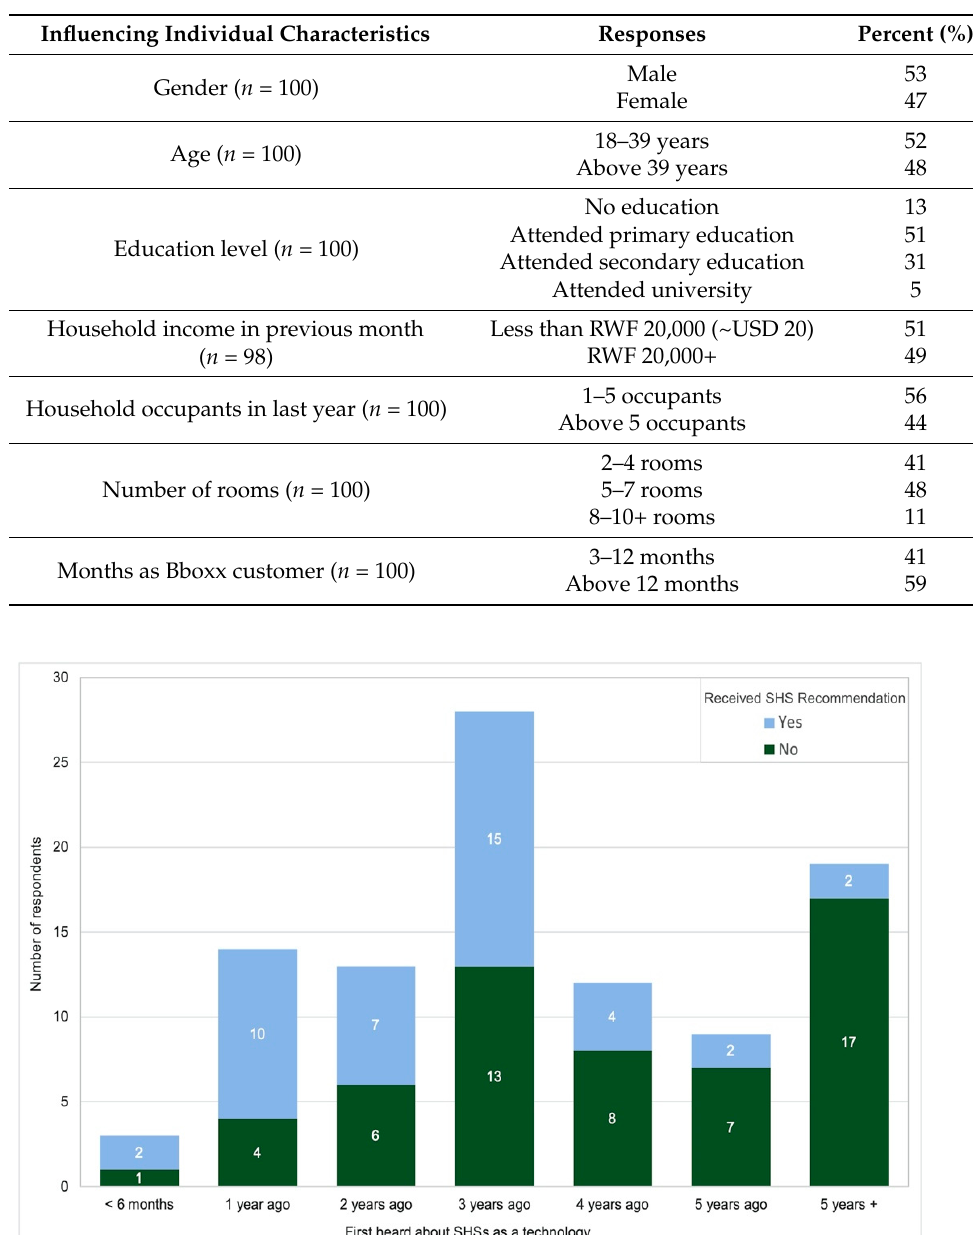
Table 3. Participant’s influencing individual characteristics.